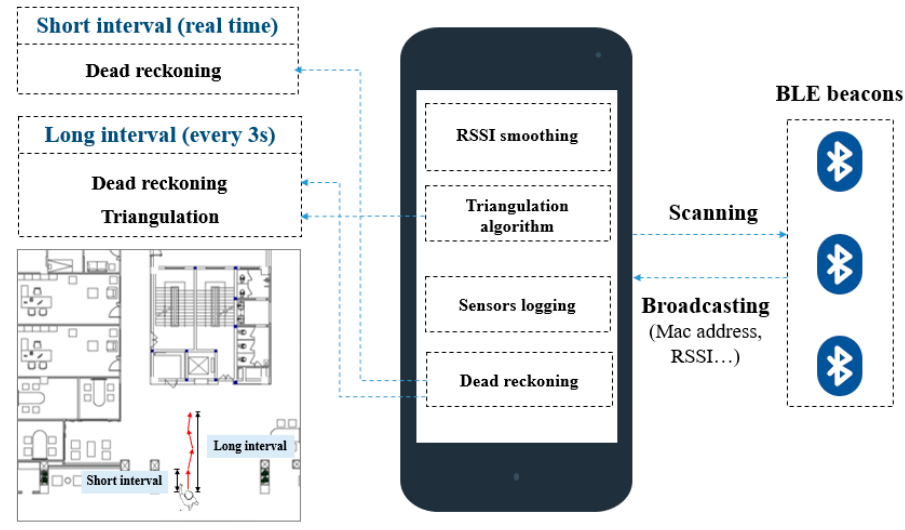
Figure 2. The overview of BLE positioning solution.